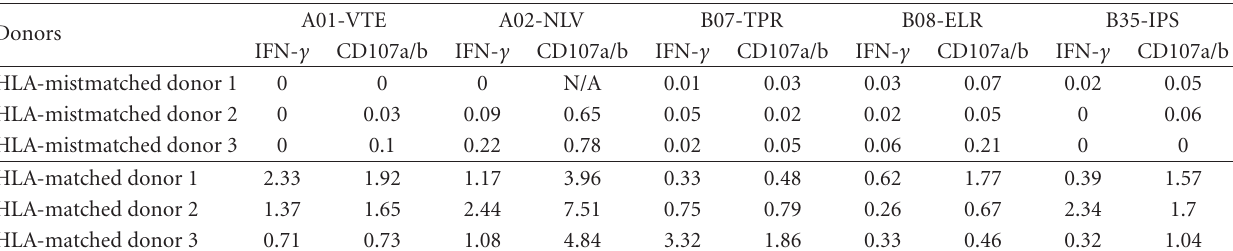
Table 6: Specificity of peptide stimulation assays. Values represent number of cells per mL of